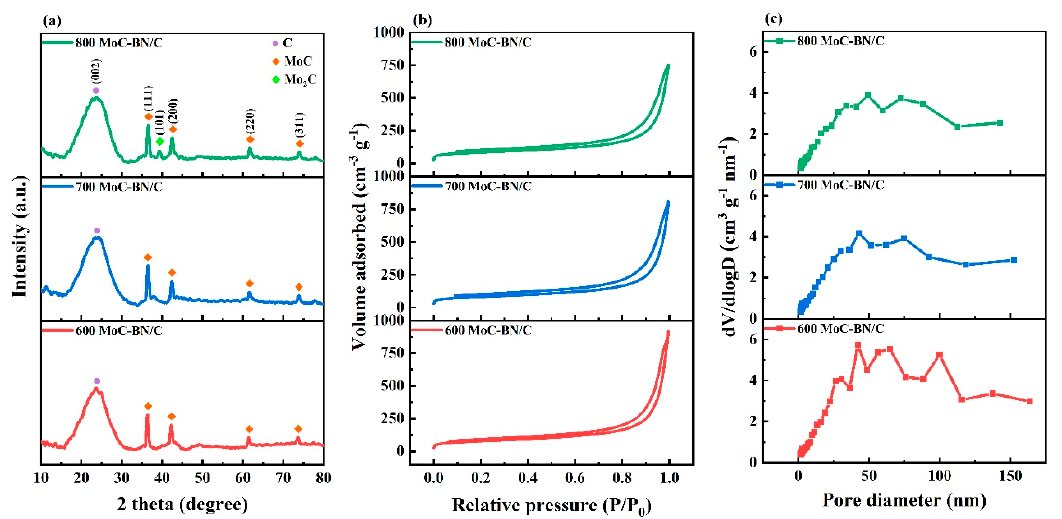
Figure 2. ( a ) XRD patterns of MoC-BN/C, ( b ) N 2 adsorption–desorption isotherm, ( c ) pore size distributions at the different heat-treatment temperatures. Table 1. Surface properties of MoC-BN / C at di ff erent heat-treatment